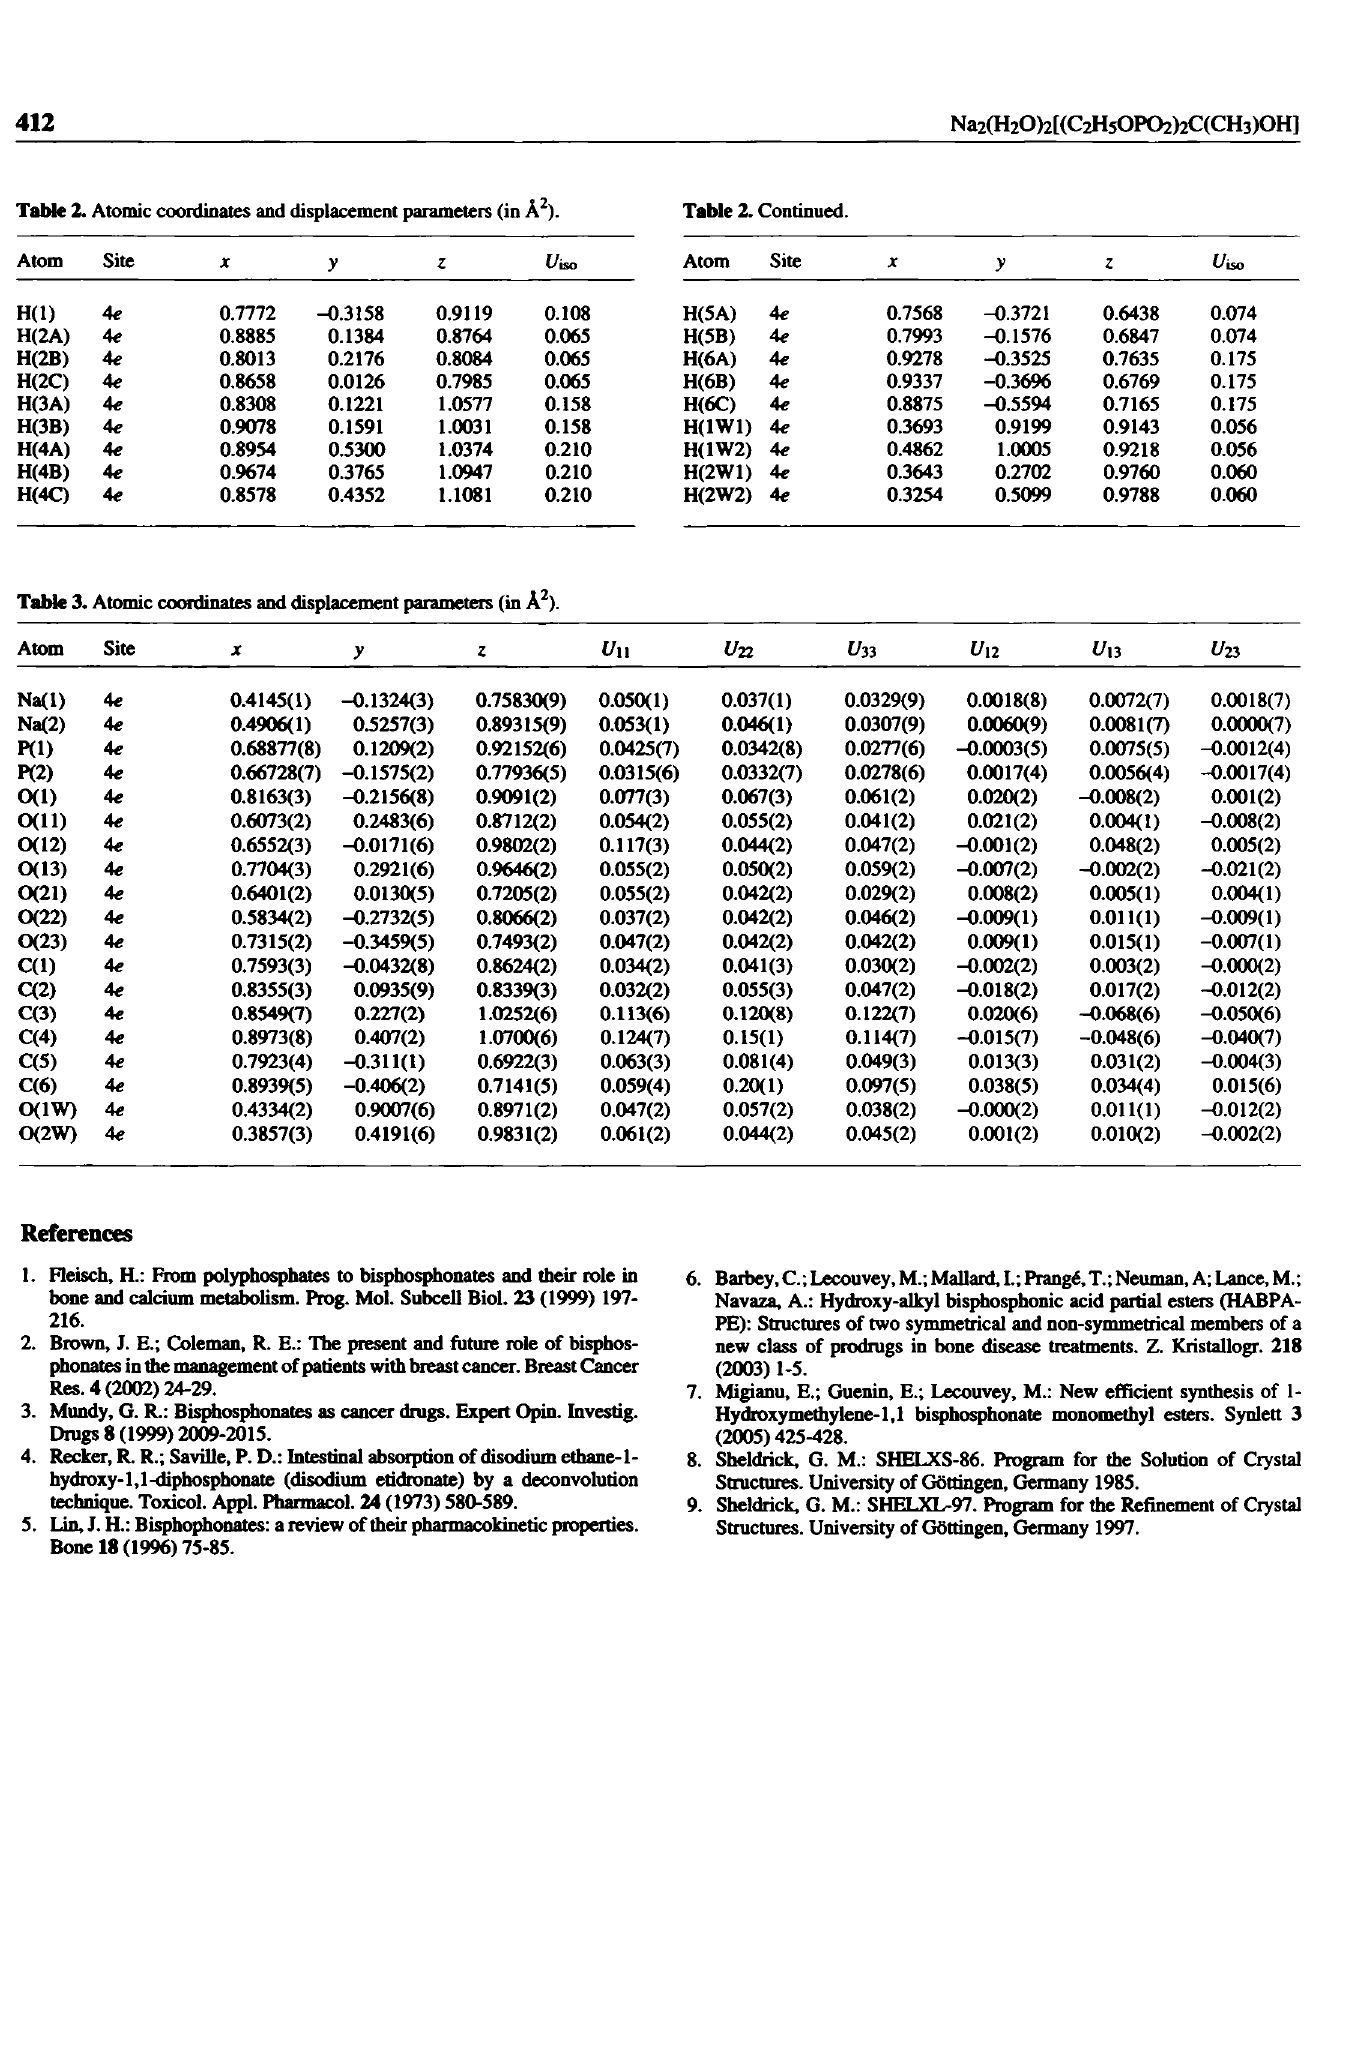
Table 3. Atomic coordinates and displacement parameters (in A 2